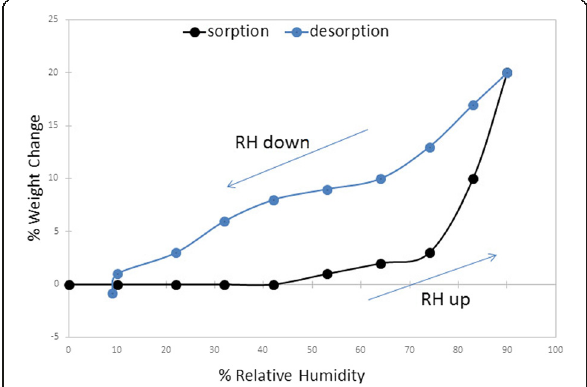
Fig. 4 Water sorption/desorption profile of indinavir (adapted from Ref (Lin et al. 1998))